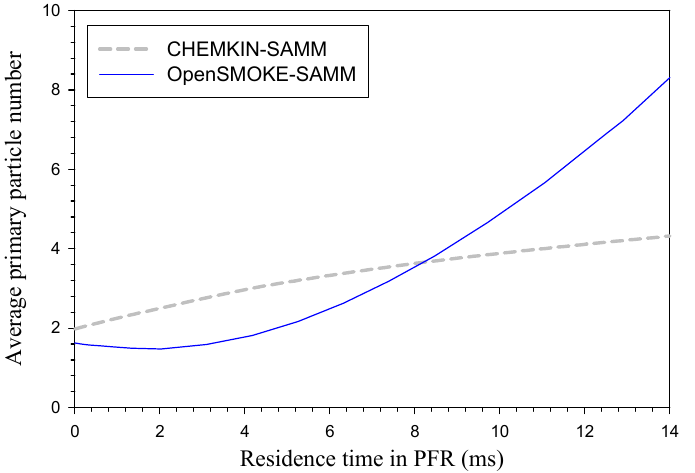
Figure 6. Comparison of the average primary particle number predicted by OpenSMOKE-SAMM and CHEMKIN-SAMM.